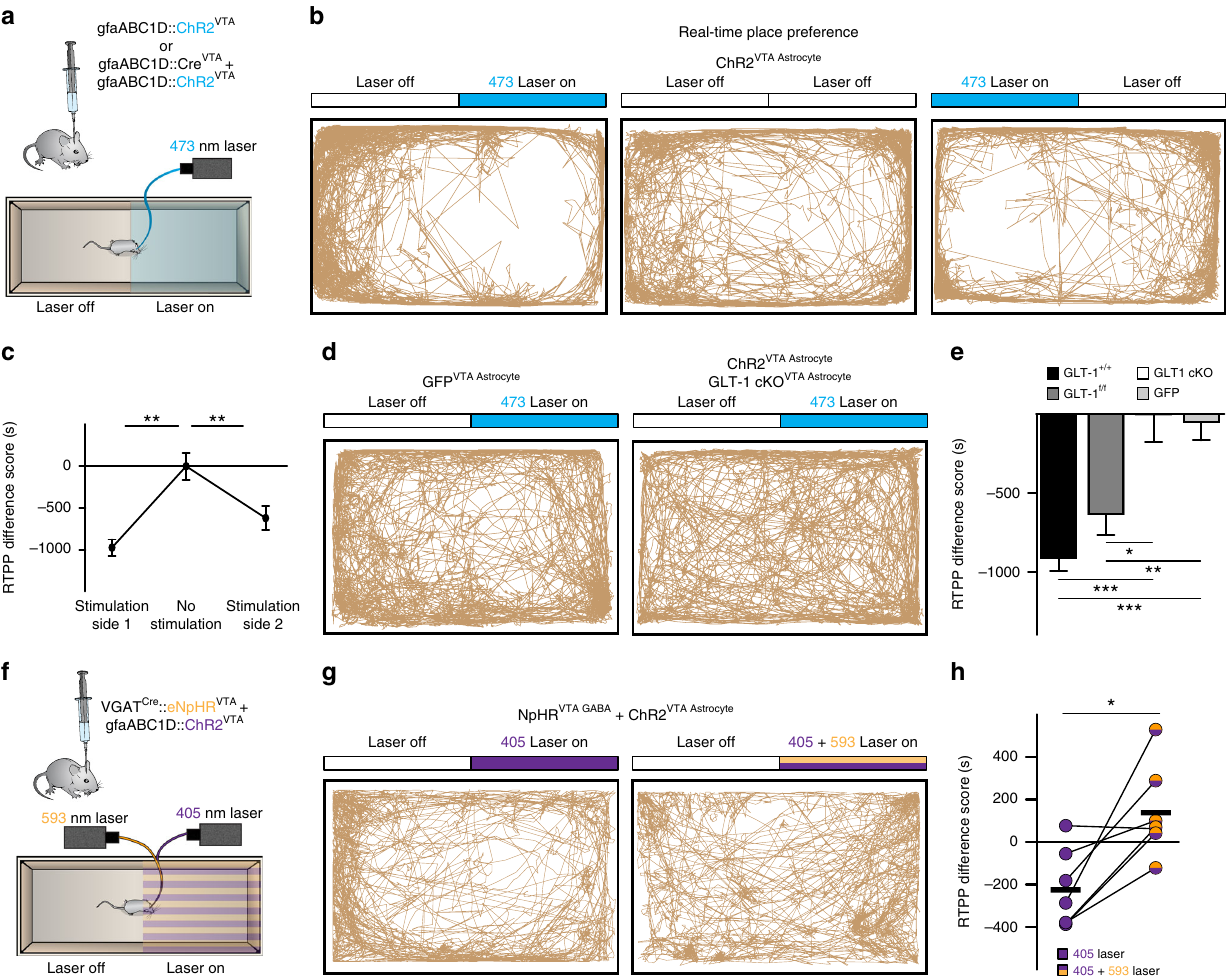
Fig. 6 Real-time avoidance is dependent on VTA astrocytes and mediated by local GABA neurons. a Experimental manipulations for panels b – e . b Three track plots from one ChR2 VTA Astrocyte mouse (GLT-1 + / + , gfaABC1D::ChR2 VTA ). (left) The mouse avoided the side of the chamber where ChR2 was stimulated in the VTA (473 nm Laser on). When the laser was left off both sides (Laser off) the mouse showed no avoidance. (right) With laser stimulation on the opposite side, the mouse then avoided the opposite side. c Summarized data showing avoidance of the laser-paired side (Repeated Measures ANOVA, F (1.413, 11.3) = 18.43, P = 0.0006; post-hoc Tukey ’ s test, stimulation side 1 vs no stimulation P < 0.05, stimulation side 1 vs stimulation side 2 P > 0.05, Stimulation side 2 vs no stimulation P < 0.05, n = 9 mice). d (left) Track plot from a mouse expressing GFP on VTA astrocytes (GFP VTA Astrocyte ; GLT-1 f/f , gfaABC1D::GFP VTA ) shows no avoidance. (Right) track plot from a mouse expressing ChR2 on, but with GLT-1 conditionally knocked out from, VTA astrocytes (GLT-1 cKO VTA Astrocyte ; GLT-1 f/f , gfaABC1D::ChR2 VTA + gfaABC1D::Cre VTA ) showing no avoidance. e Summarized data showing avoidance elicited by ChR2 activation in GLT-1 + / + and GLT-1 f/f mice. However, loss of GLT-1 from VTA astrocytes eliminates avoidance (One-way ANOVA, F (3,49) = 16.11, P = 0.0001; post-hoc Tukey ’ s test, GLT-1 f/f ( n = 10) relative to: GLT-1 cKO VTA Astrocyte P < 0.05, GLT-1 + / + P > 0.05 ( n = 18), GFP P < 0.05 ( n = 14); cKO VTA Astrocyte ( n = 11) relative to: GLT-1 + / + P > 0.05, GFP P < 0.05; GLT-1 + / + P < 0.05). f Experimental manipulations for panels g – h . g Track plots from a VGAT CRE ::eNpHR VTA mouse with ChR2 stimulation on VTA astrocytes (eNpHR VTA GABA + ChR2 VTA Astrocyte ). Avoidance observed during ChR2 stimulation (left; ChR2 stimulated at 405 nm to minimize activation of eNpHR) was blocked when astrocytes were photoactivated concurrently with GABA neuron hyperpolarization (right). h Summarized data demonstrating GABA neuron hyperpolarization blocks avoidance elicited by ChR2 on VTA astrocytes.** P < 0.01, * P < 0.05; Error bars indicate ±